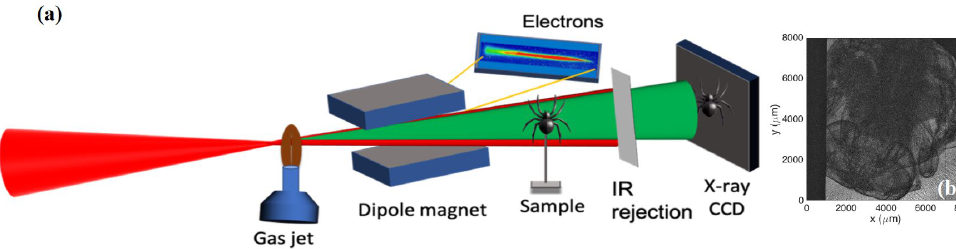
Figure 11. ( a ) Schematic of the propagation-based XPCI using a Betatron source. ( b ) XPCI of a dry bee-fly using a Betatron